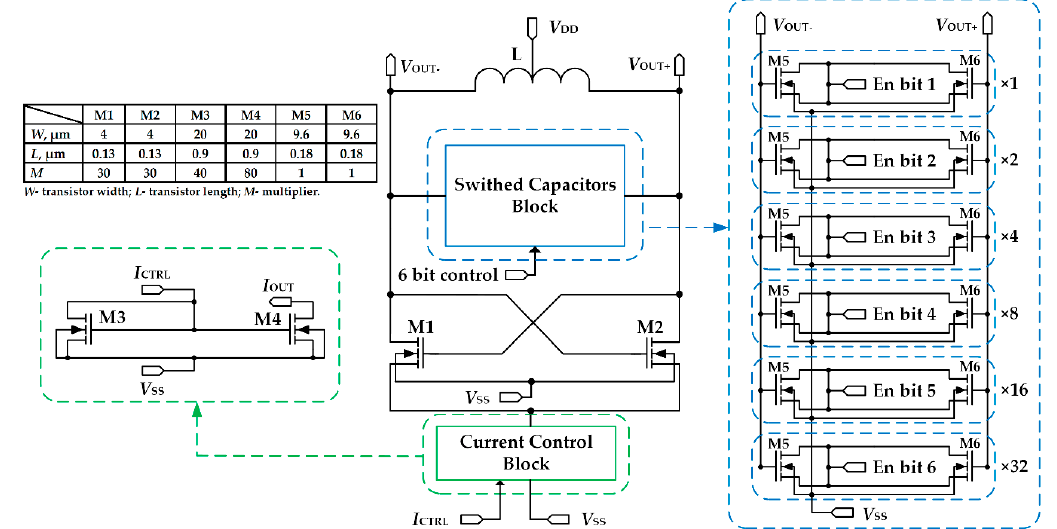
Figure 4. Schematic of the proposed LC DCO.